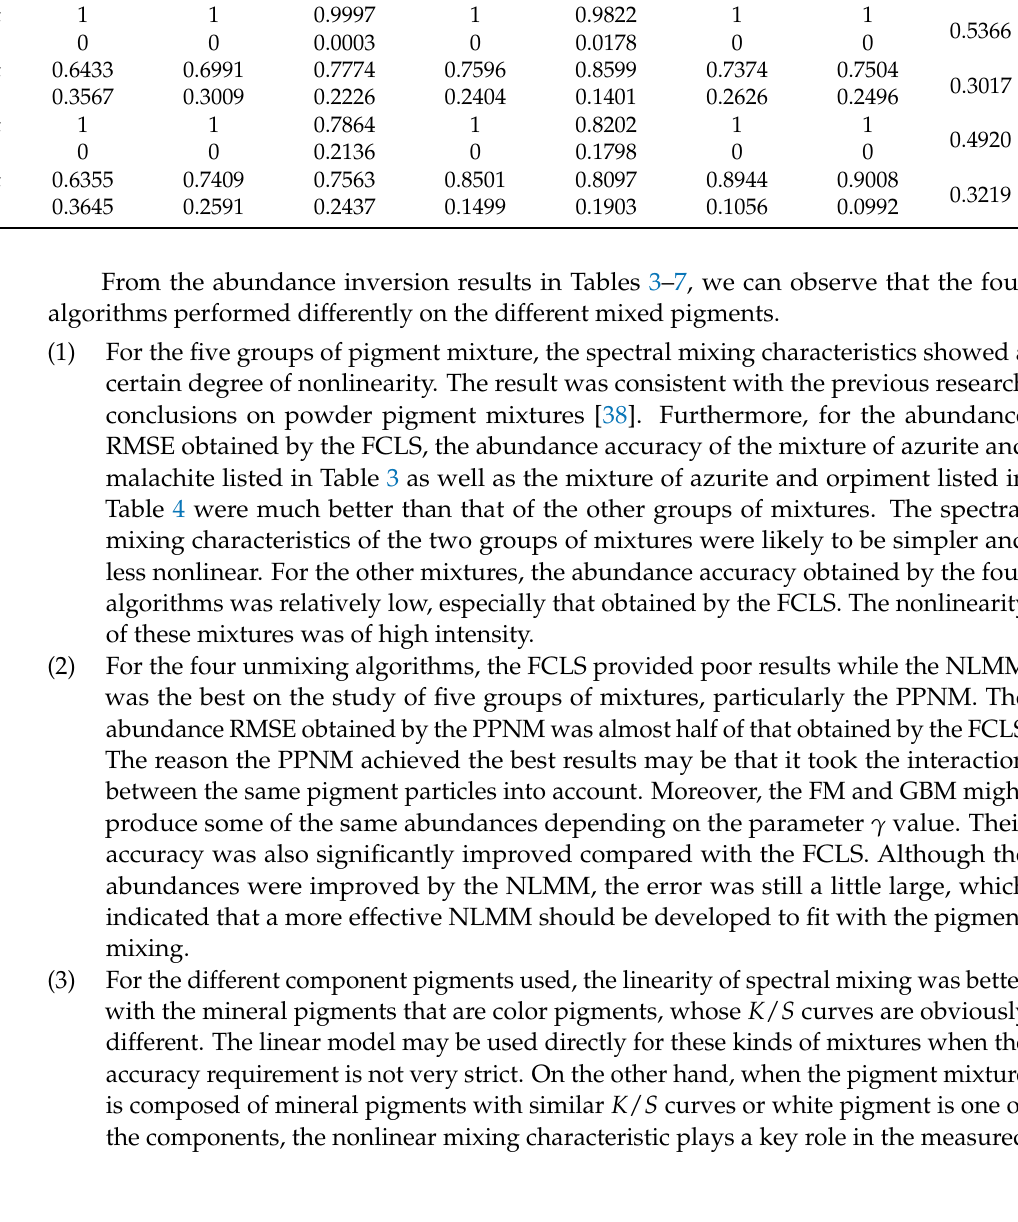
Table 7. Abundance estimated by different approaches for mixed pigment samples of orpiment and calcite. Abundance